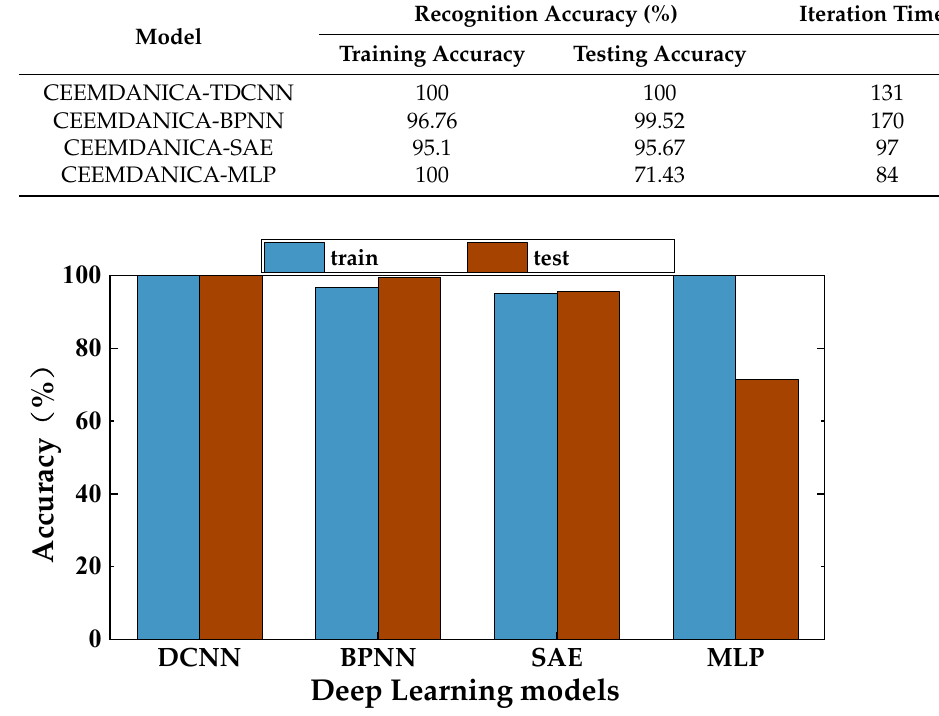
Figure 11. Classification confusion matrix of CEEMDANICA-TDCNN.